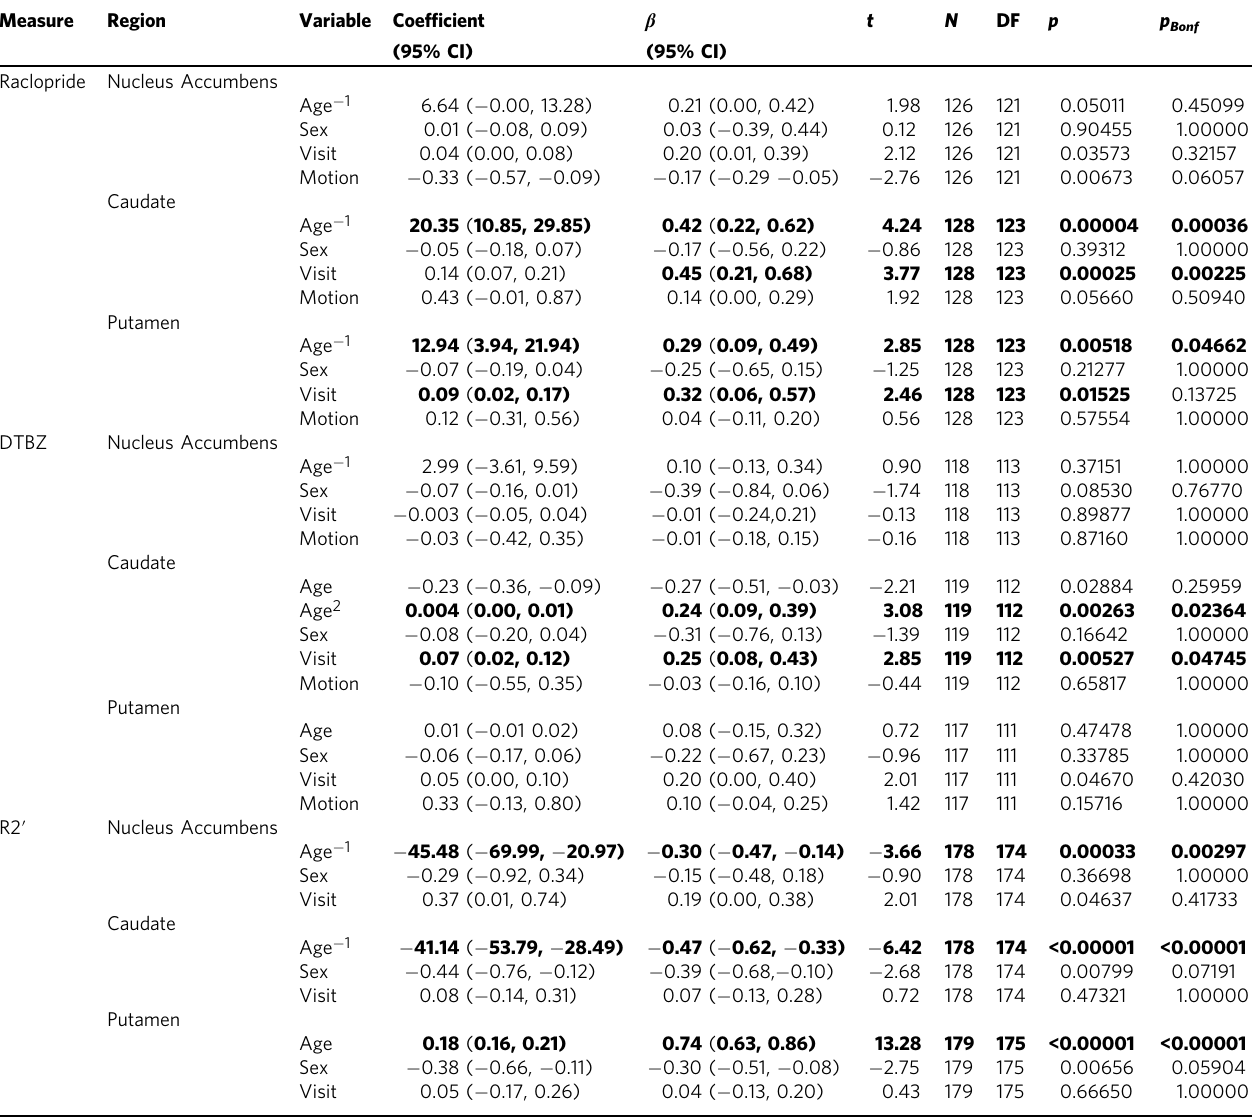
Table 1 Linear mixed effects regression table for age models. Measure